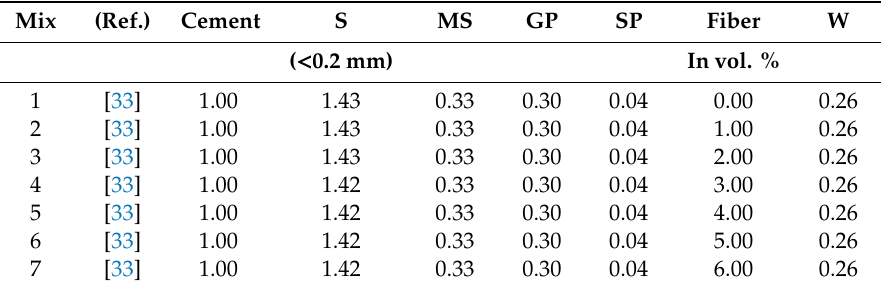
Figure 3. Experimental and designed compressive strength after 28 days for different amounts of fibers [33]. Table 5. Mixture proportions [33].